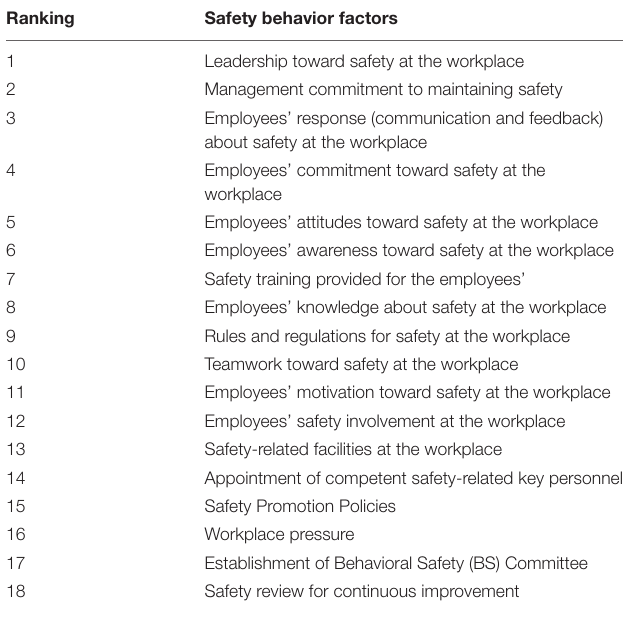
TABLE 1 | Ranking of safety behavior